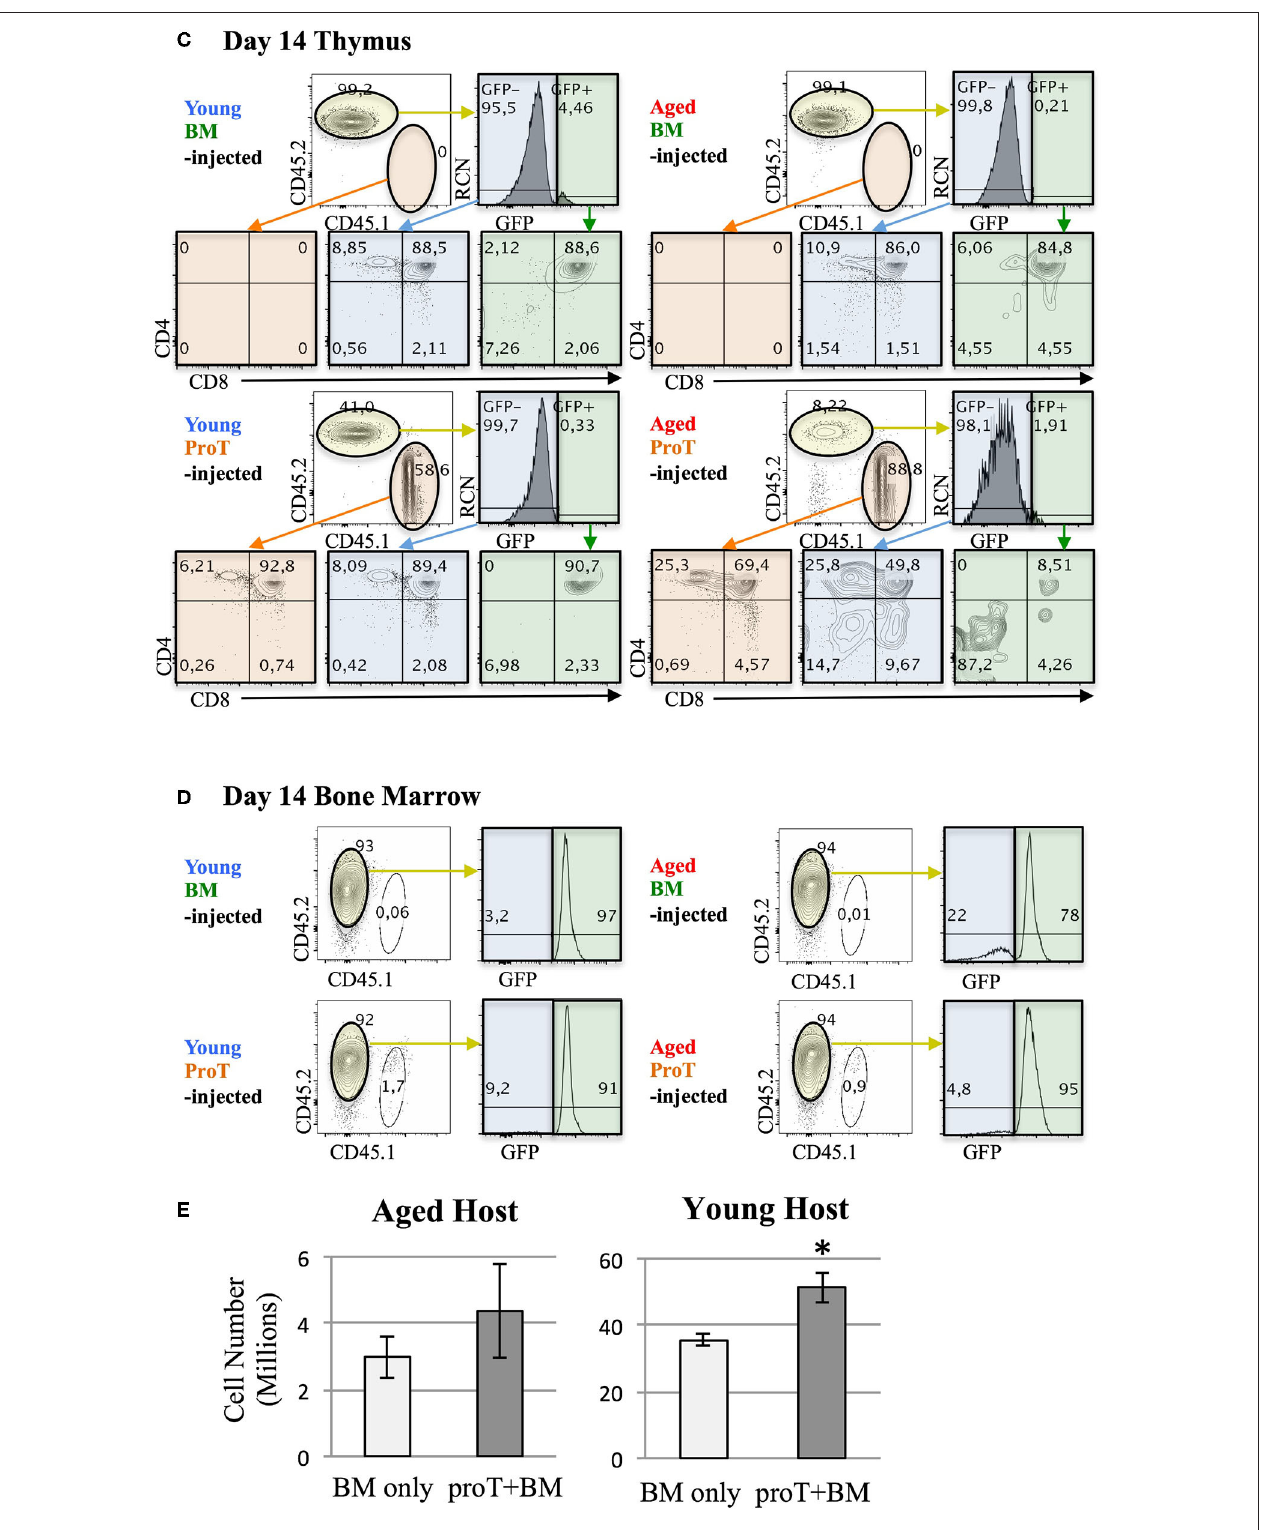
FIGURE 4 | Adoptive transfer of mouse proT cells into lethally-irradiated aged mice. A schematic for experiments is shown (A) . LSK/OP9-DL co-cultures were initiated 10 days prior to injection. 18-month old (Aged) and 3-month old (Young) wild-type C57BL/6 (CD45.2) mice were irradiated at 1.025Gy on the day of